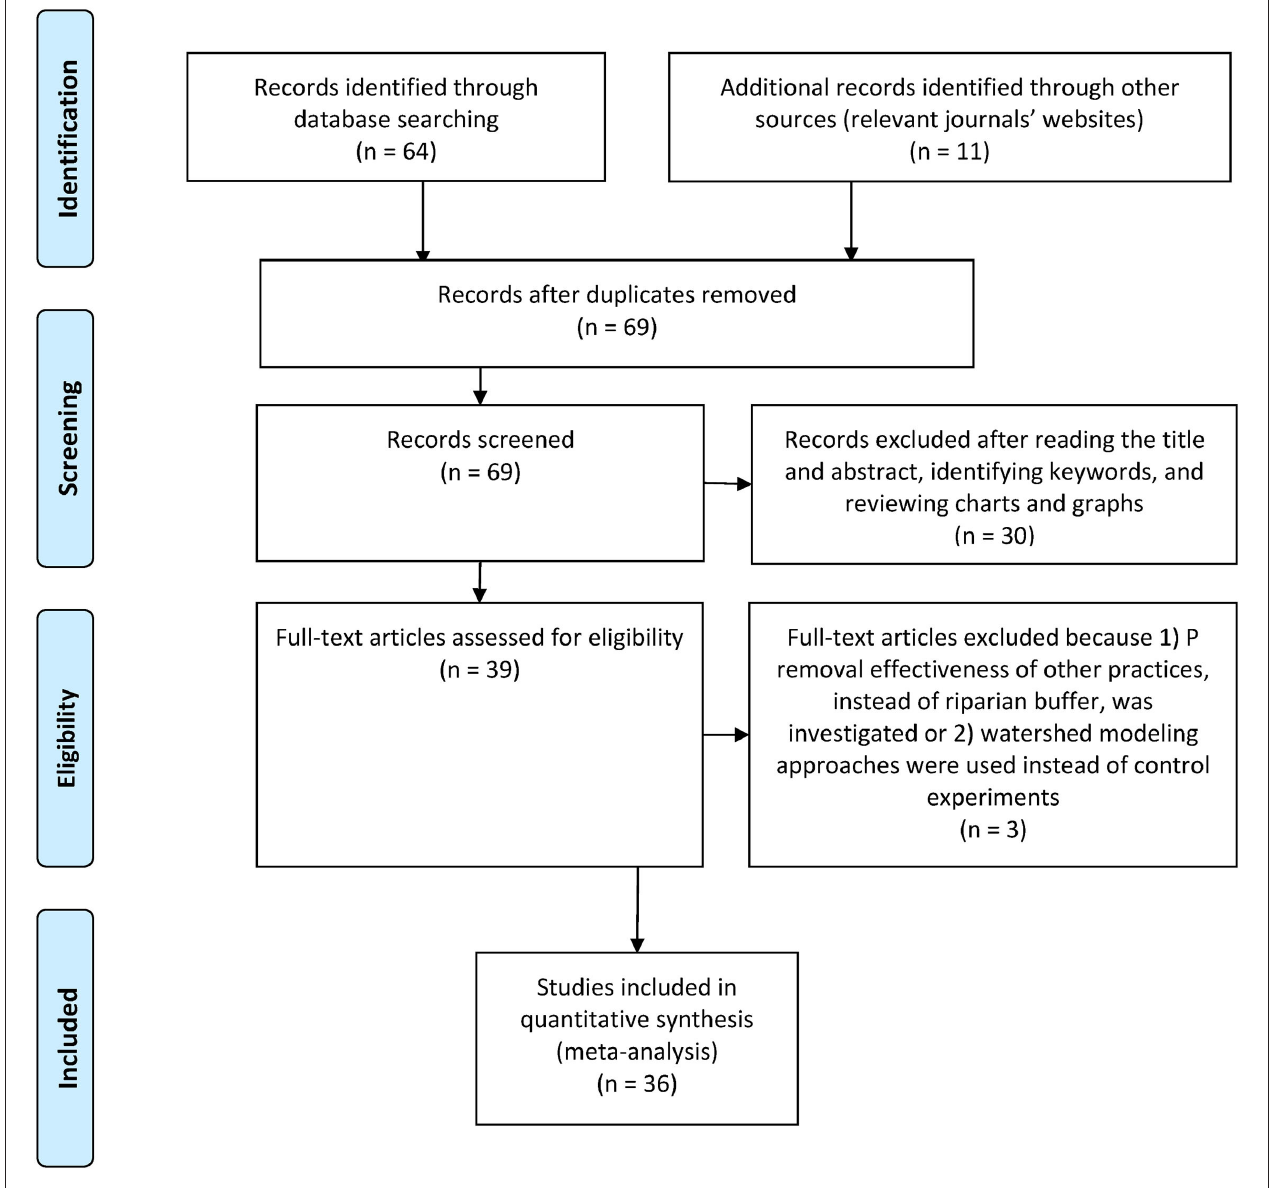
FIGURE 1 | PRISMA flow diagram of our literature